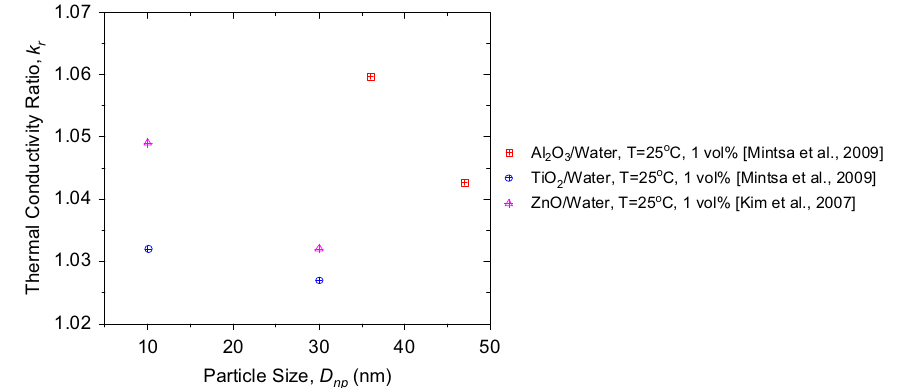
Figure 6: E ff ect of nanoparticle size on thermal conductivity in a base fl uid of